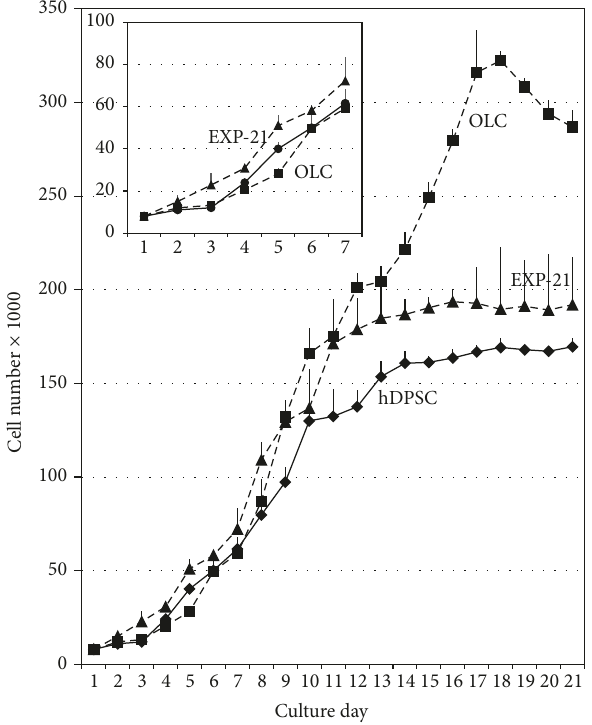
Figure 4: Cell growth curves . The hDPSC, OLC, and EXP-21 cells were detached daily for 21 days to determine the average number of cells in each cell population. hDPSC were maintained in culture medium without differentiation factors for 21 days, the OLC were stimulated with differentiation medium, and EXP-21 cells were maintained with differentiation medium for additional 21 days after detaching. Data are shown as mean ± SD and are based on three independent experiments and each was quantitated by triplicate ( 𝑛 = 9